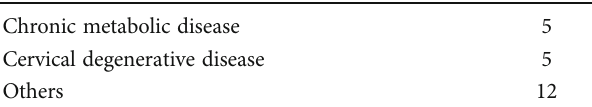
Table 1: Baseline clinical data, medications, and complications. Table 1: